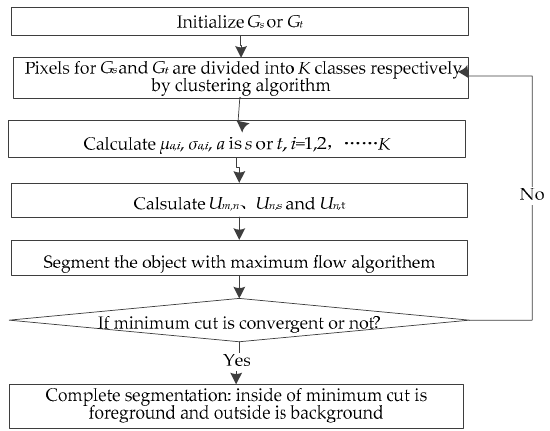
Figure 3. Flow chart of GrabCut algorithm for segmentation of ice-covered in-service glass insulators.